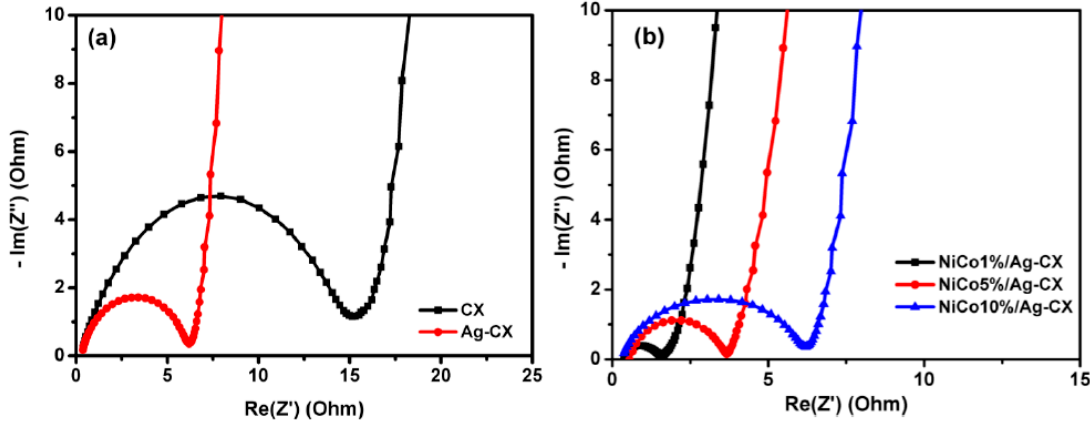
Figure 7. Nyquist plot for ( a ) CX and Ag-CX and ( b ) NiCo1/Ag-CX, NiCo5/Ag-CX, and NiCo10/Ag- CX.